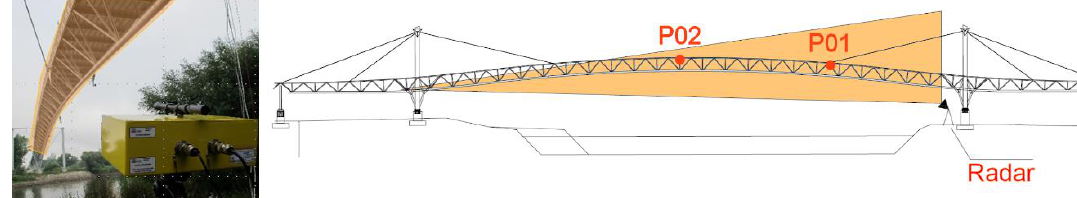
Figure 8. Position of the ground-based radar.